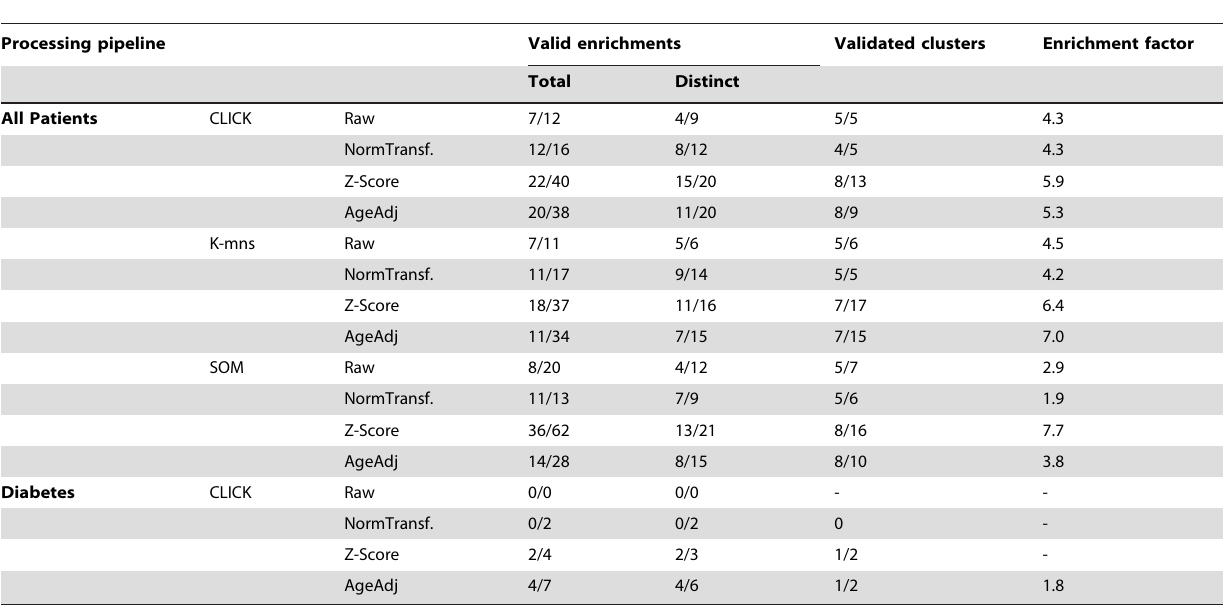
Table 2. Comparative enrichment analysis of biomarker-based patient clusters: A quantitative analysis.